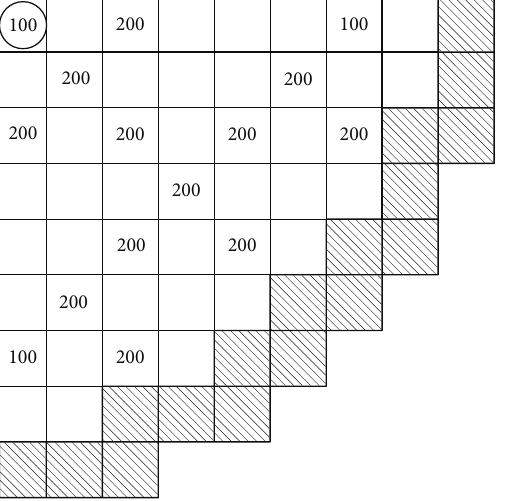
Figure 5: The initial control rod positions for case B2 (circled position is